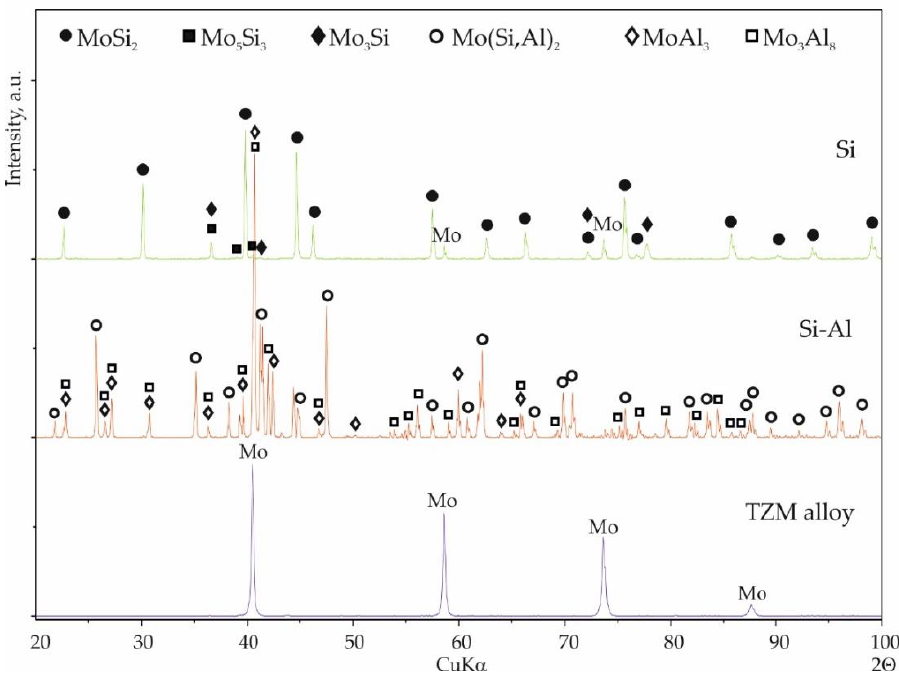
Figure 3. XRD patterns of Si and Si-Al coating obtained on TZM alloy at temperature 1000 °C in 2 h with a quantity of slurry 0.3 g/cm 2 .